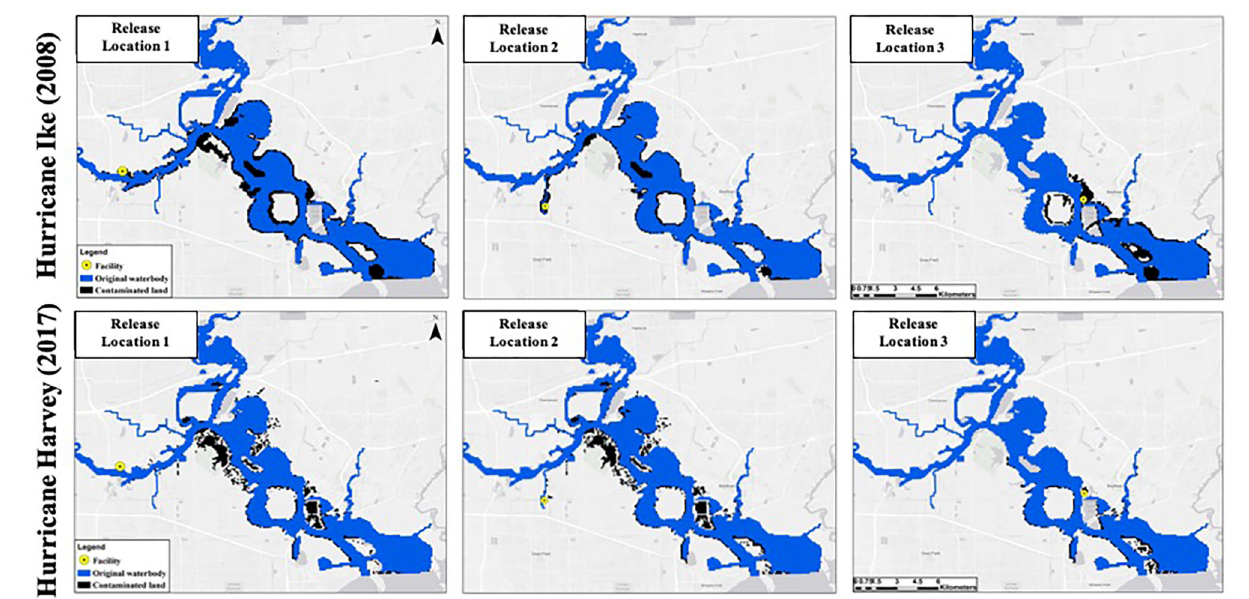
FIGURE 9 | Comparison of land affected by spills from different locations within the model domain for Hurricane Ike (top) and Hurricane Harvey (bottom).